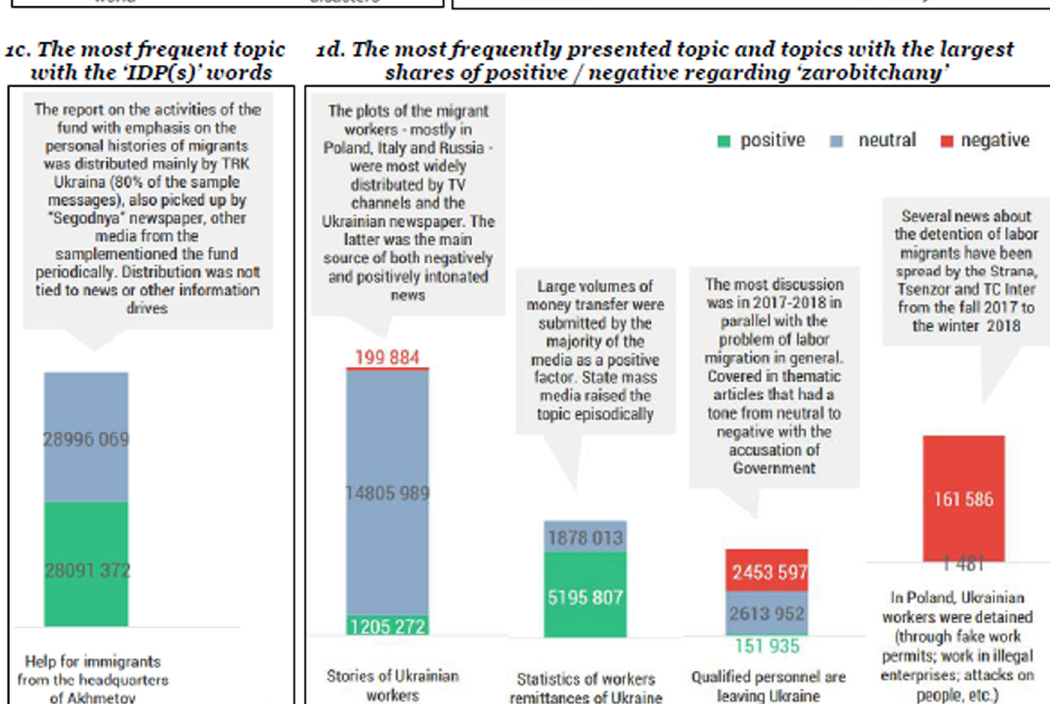
Fig. 1 Some key informational drives on migration and migrants in the top Ukrainian media (2015 – 2018). Source: The Center for Content Analysis elaboration based on quantitative media content analysis (infodrives for illustration were selected and combined by L. Yuzva). Data source: The Center for Content Analysis research based on quantitative media content analysis, 2019. The bar charts report the number of media mentions of searched terms ( a — ‘ migrants ’ , b — ‘ refugees ’ , c — ‘ IDP(s) ’ , d — ‘ zarobitchany ’ ) whose tone of messages was color-coded (green indicates positive mentions, blue indicates neutral mentions, red indicates negative mentions). The other colors do not have a semantic load and are used to delimit areas for the sake of visual